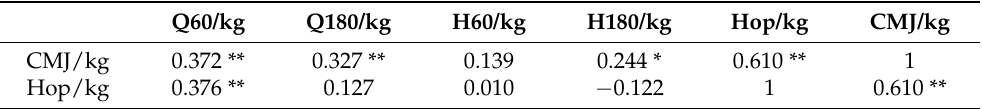
Table 4. Spearman’s correlation between relative isokinetic strength and jump performances in volleyball